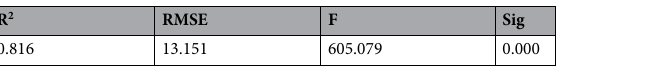
Table 1. Multivariate regression model results in forecasting NO 2 concentration in Tehran city.